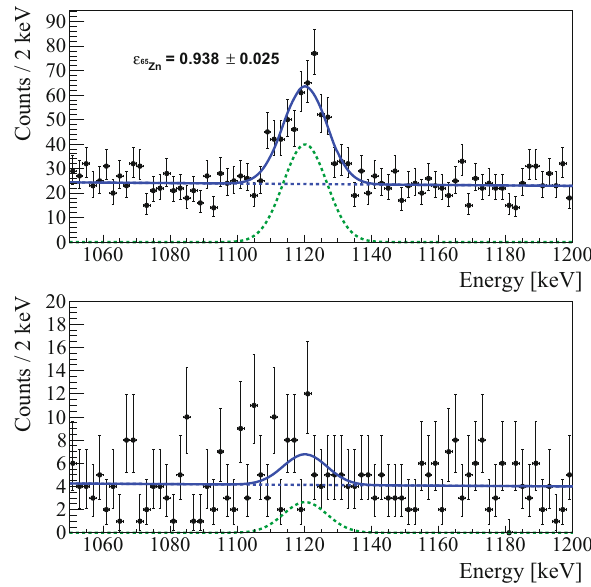
Fig. 4 γ peak of 65 Zn recorded in half a DataSet (even events). Top: events that pass the pulse-shape cuts and the anti-coincidence cut. Bot- tom: events rejected by the pulse-shape cuts. We fit both the plots simul- taneously with an unbinned extended maximum likelihood fit with two components: a Gaussian function and an exponential background using the RooFit analysis